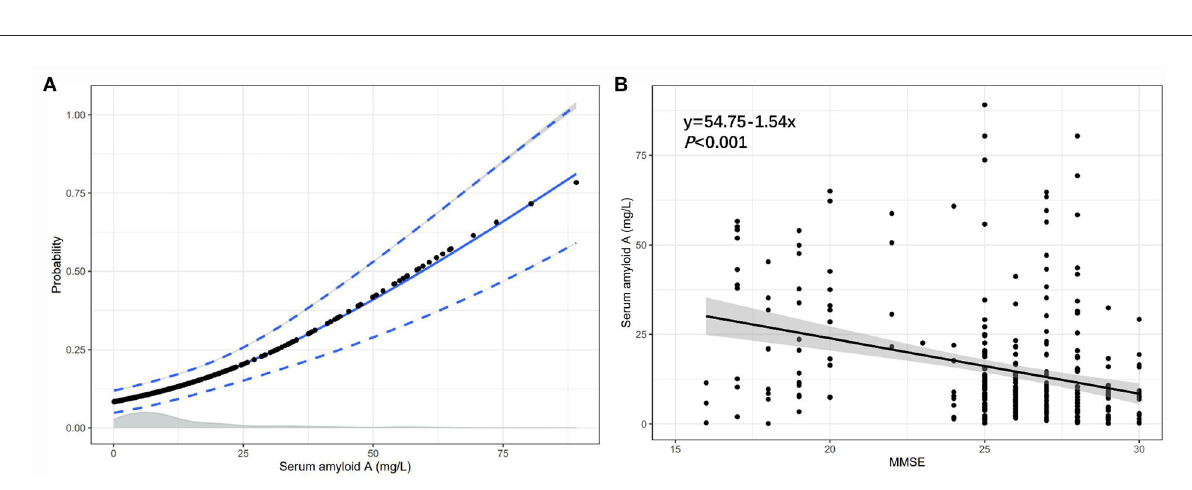
FIGURE6 The association between the serum SAA and the probability of PSCI, the serum SAA, and the MMSE score. (A) The association of SAA levels with the probability of PSCI in patients with lacunar infarction; (B) The association between SAA levels and MMSE